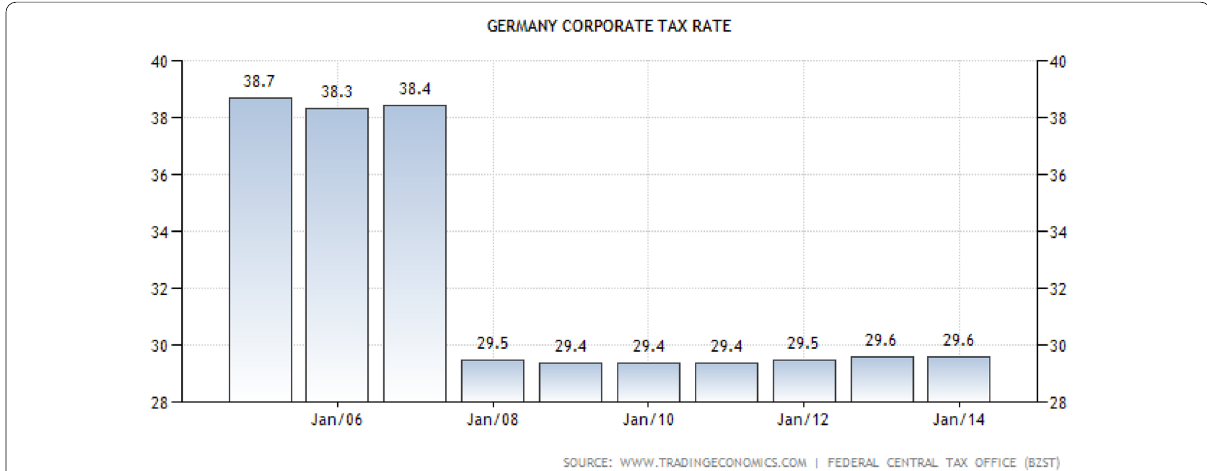
Fig. 1 The Netherlands corporate tax